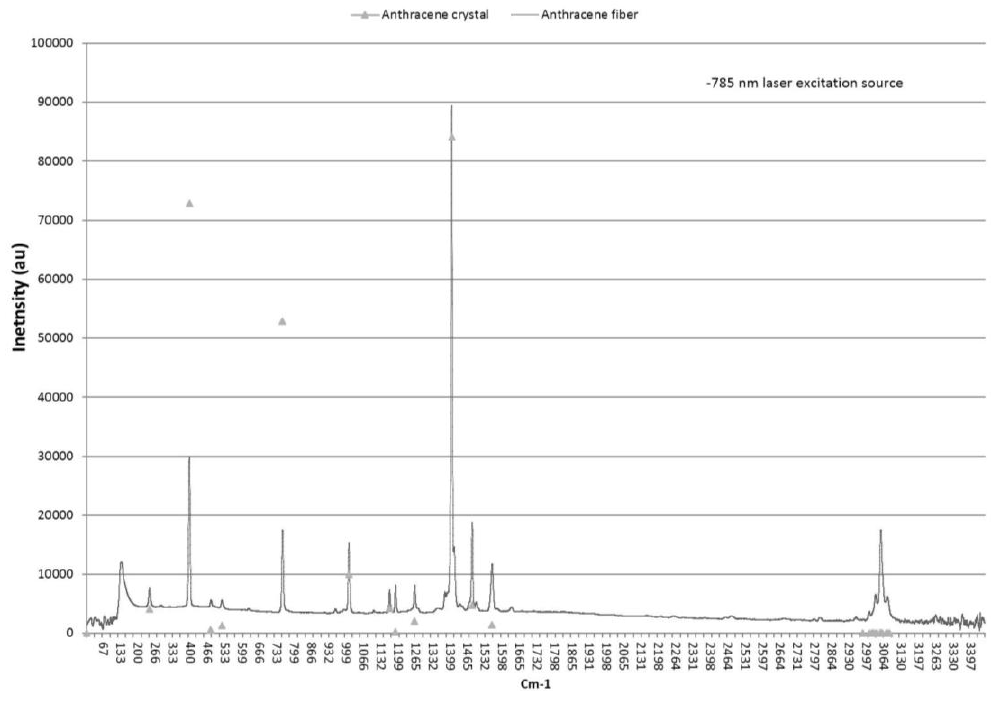
Figure 6. Raman spectra from anthracene fiber in the quartz matrix. Fiber data has ±1 cm −1 agreement with anthracene crystal data spectrum (indicated by triangular markers)